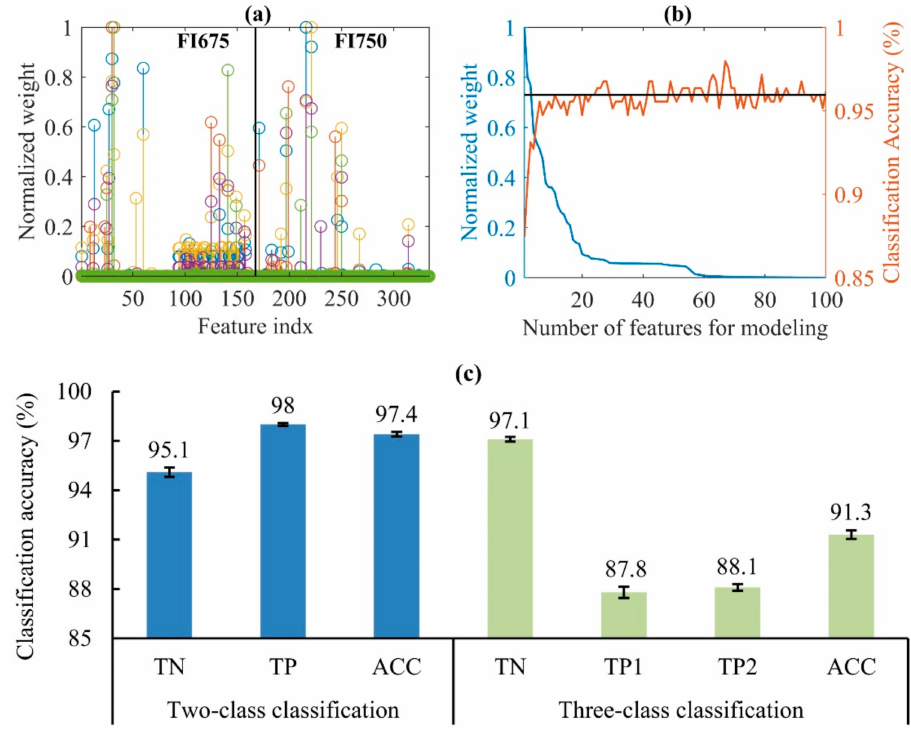
Figure 9. ( a ) Normalized feature weights obtained by neighborhood component analysis feature selection for one modeling replicate of two-class classification based on FI675-FI750, ( b ) the top 100 ranked features from ( a ) and the corresponding classification accuracies, where the black horizontal line indicates the classification accuracy using a full set of features, and ( c ) two-class and three-class classification accuracies using selected subsets of features, where the definitions of TN, TP, TP1, TP2 and ACC are given in Figure 8. Error bars in the chart indicate the corresponding standard errors for 30 modeling